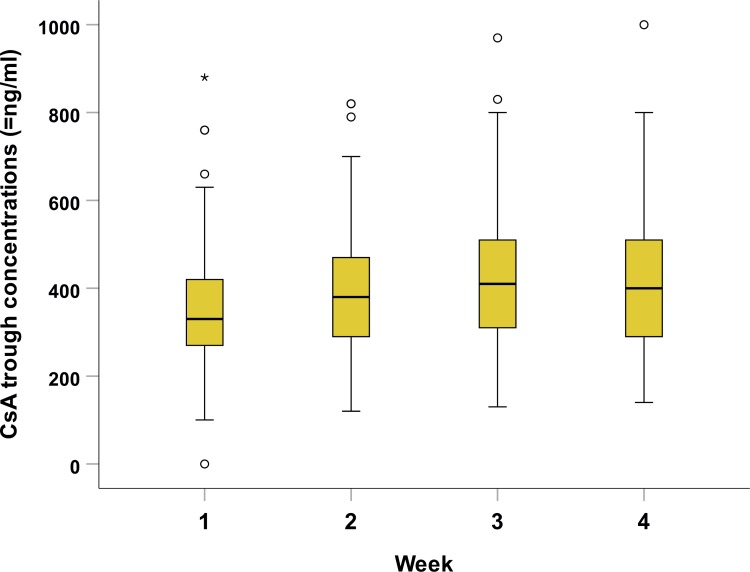
Summary of CsA trough concentration measured 1 to 4 weeks after HCT.